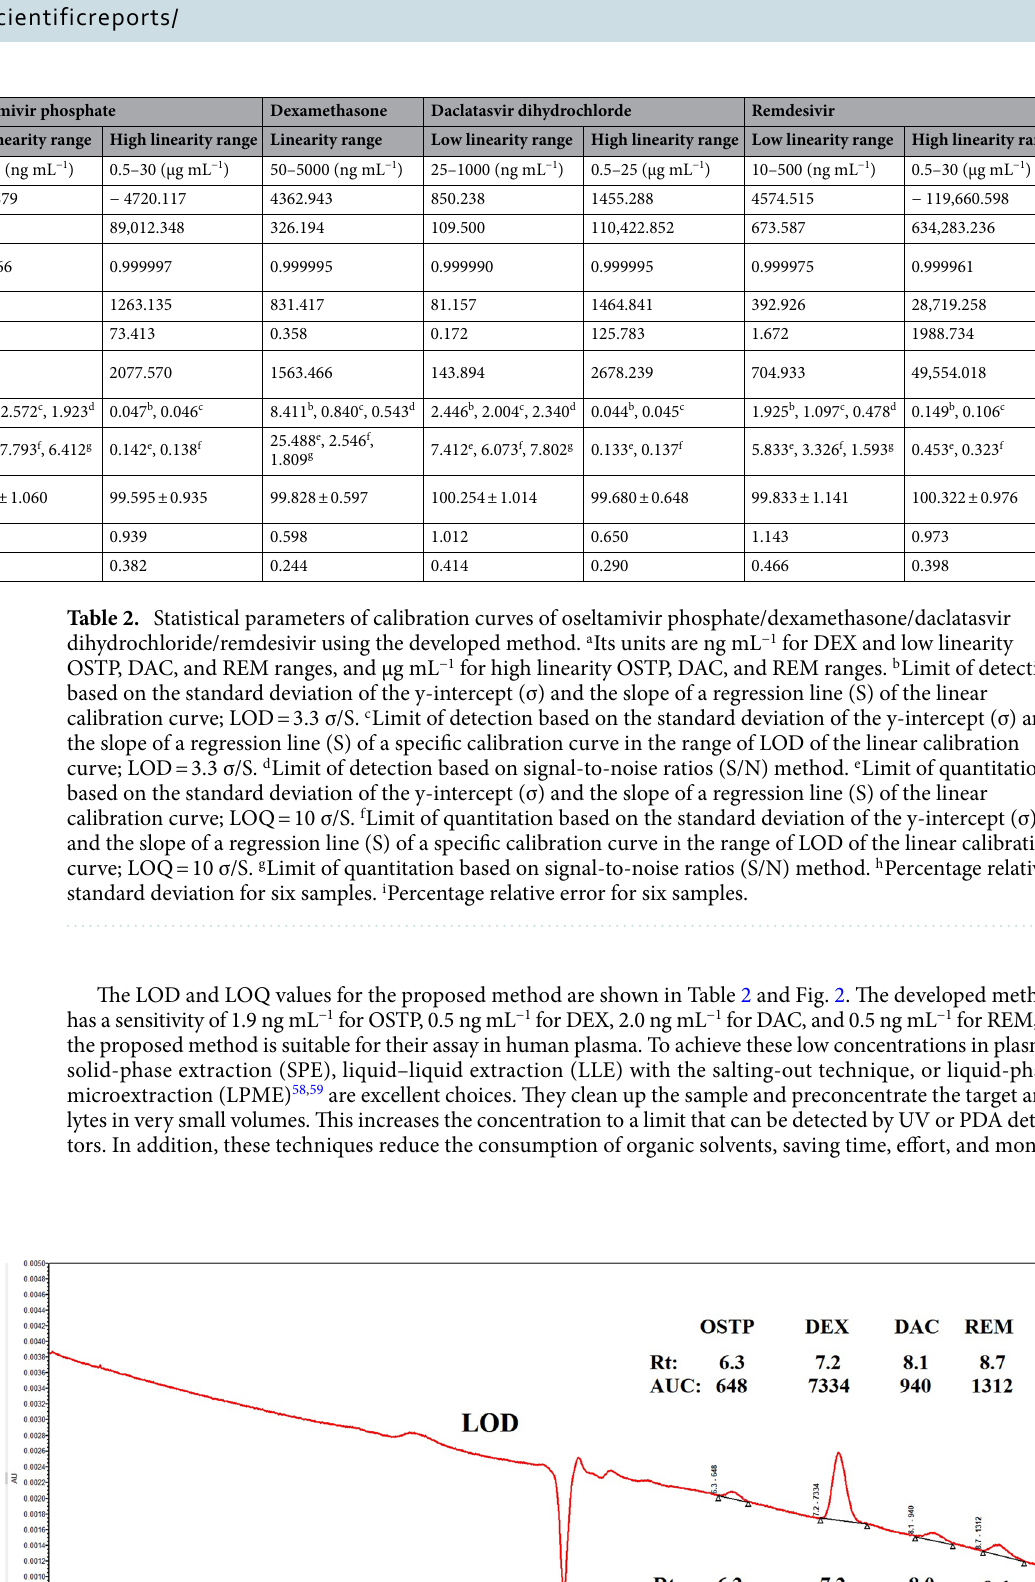
Figure 2. Chromatograms by the proposed method for: Limit of detection (LOD): ≈ 2 ng mL −1 OSTP, ≈ 8 ng mL −1 DEX, ≈ 2 ng mL −1 DAC, and ≈ 0.5 ng mL −1 REM. Limit of quantitation (LOQ): ≈ 6 ng mL −1 OSTP, ≈ 25 ng mL −1 DEX, ≈ 6 ng mL −1 DAC, and ≈ 1.6 ng mL −1